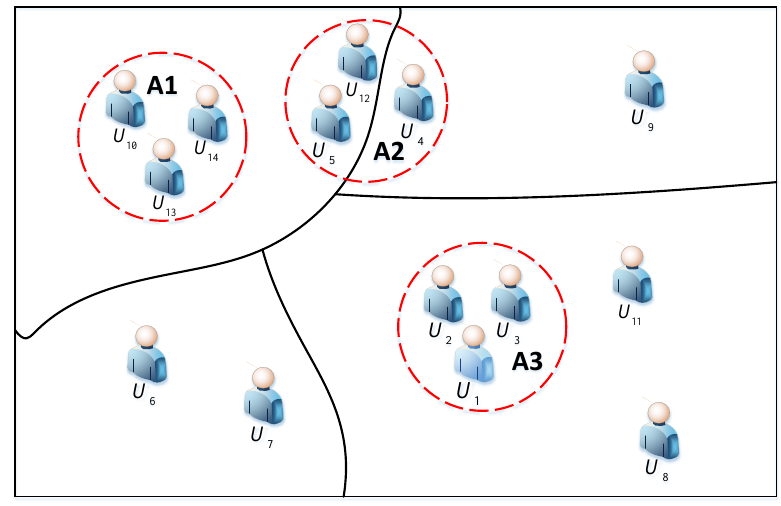
Figure 3. An example of users’ organization information